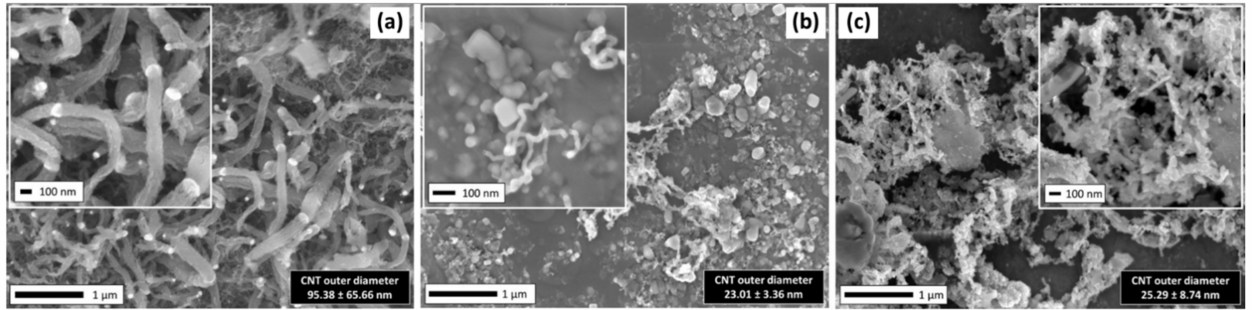
Figure 5. FESEM images of samples synthesized from ( a ) ethanol, ( b ) NRS-L and ( c ) NRG-S precursors. Raman spectroscopy was employed to characterize the quality of synthesized